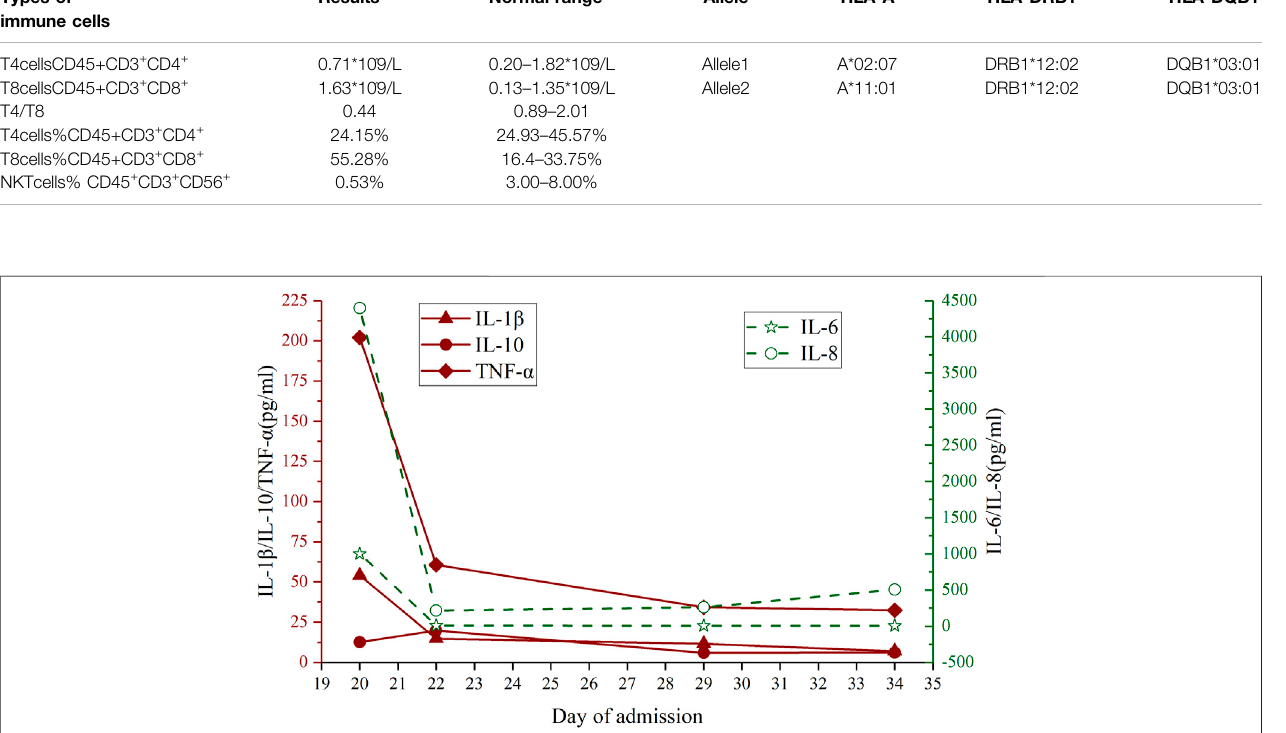
FIGURE 2 | Changes in IL-1 β , IL-6, IL-8, IL-10, and TNF- α levels through the clinical course.